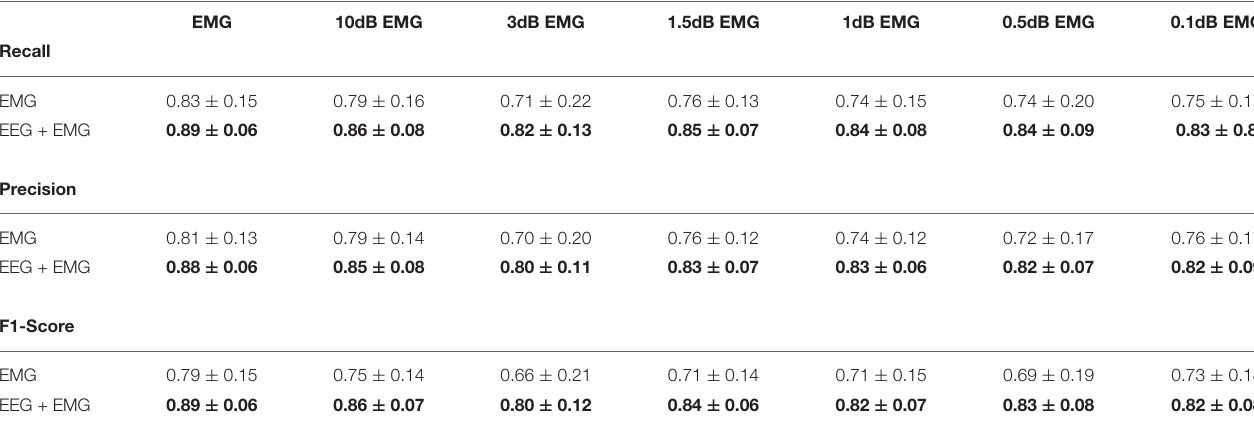
TABLE 2 | Classification performance averaged across subjects at different levels of signal-to-noise ratio (in dB) of the EMG signal using only the EMG signals or by the use of EEG and EMG signals together.